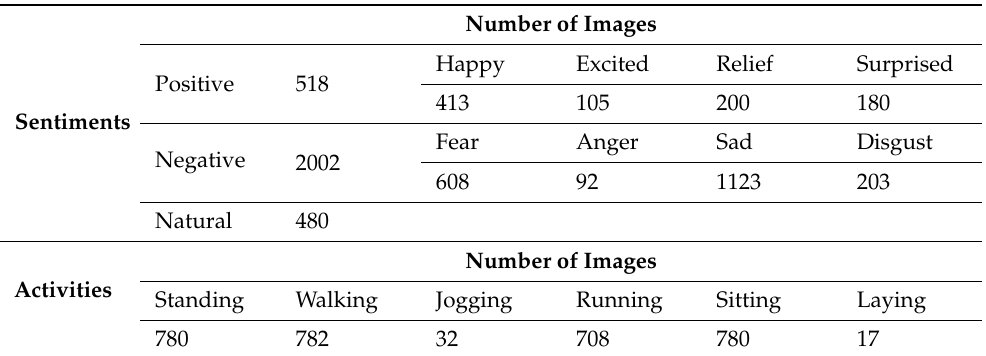
Figure 4. Sample images for human sentiment and related physical activities in the natural disaster dataset [22]. Table 3. Detailed statistics of human sentiments and related physical activities dataset. The dimension is kept at 224 × 224 for every image during